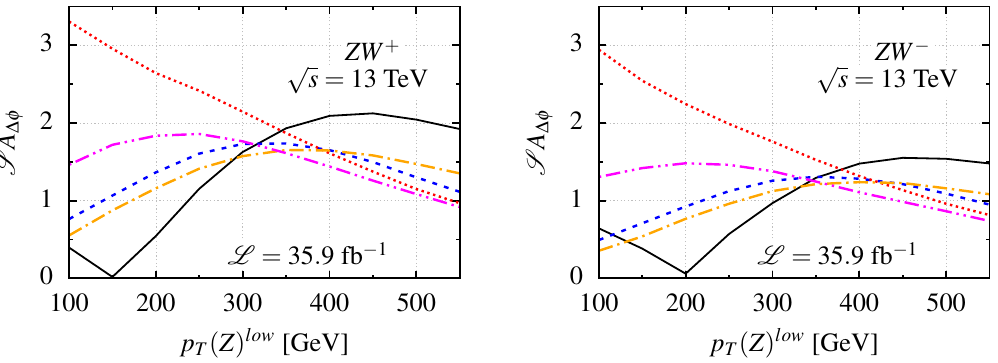
Figure 5 . The sensitivity of the asymmetry A (cid:1) (cid:30) on the (cid:12)ve benchmark aTGC as a function of the lower cut on p T ( Z ) in the ZW (cid:6) production at the LHC at p s = 13 TeV and L = 35 : 9 fb (cid:0) 1 . The legend labels are same as in (cid:12)gure